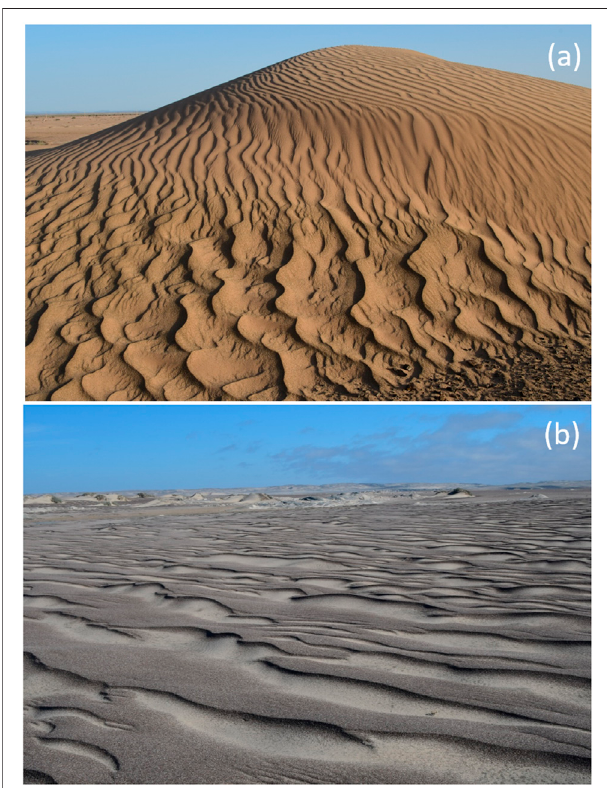
FIGURE 1 | (A) A transition between normal sand ripples at the top of a dune in Morocco near Merzouga to undulated megaripples at the bottom where coarse grains are more abundant. (B) A large fi eld of megaripples near Torra Bay, Namibia. Notice the secondary small ripples superimposed on the windward slopes of the larger megaripples (both photos by Hezi